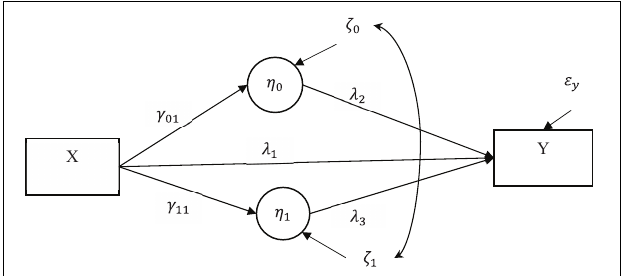
FIGURE 1 | Latent growth curve mediation model (LGCMM). The antecedent variable ( X ) was pain at 4 months after treatment. The two covarying mediators were the latent intercept ( η 0 = mean negative mood at 4 months) and slope ( η 1 = monthly rate of negative affect) for the repeated measures of negative affect. The outcome variable ( Y ) measures percent drinking days (PDD) at 16 months. C denotes a set of covariates (e.g., background variables). A single-headed arrow shows the direct effect of a variable at the origin on the variable at the end of the arrow. A curved double-headed arrow shows covariance between the two